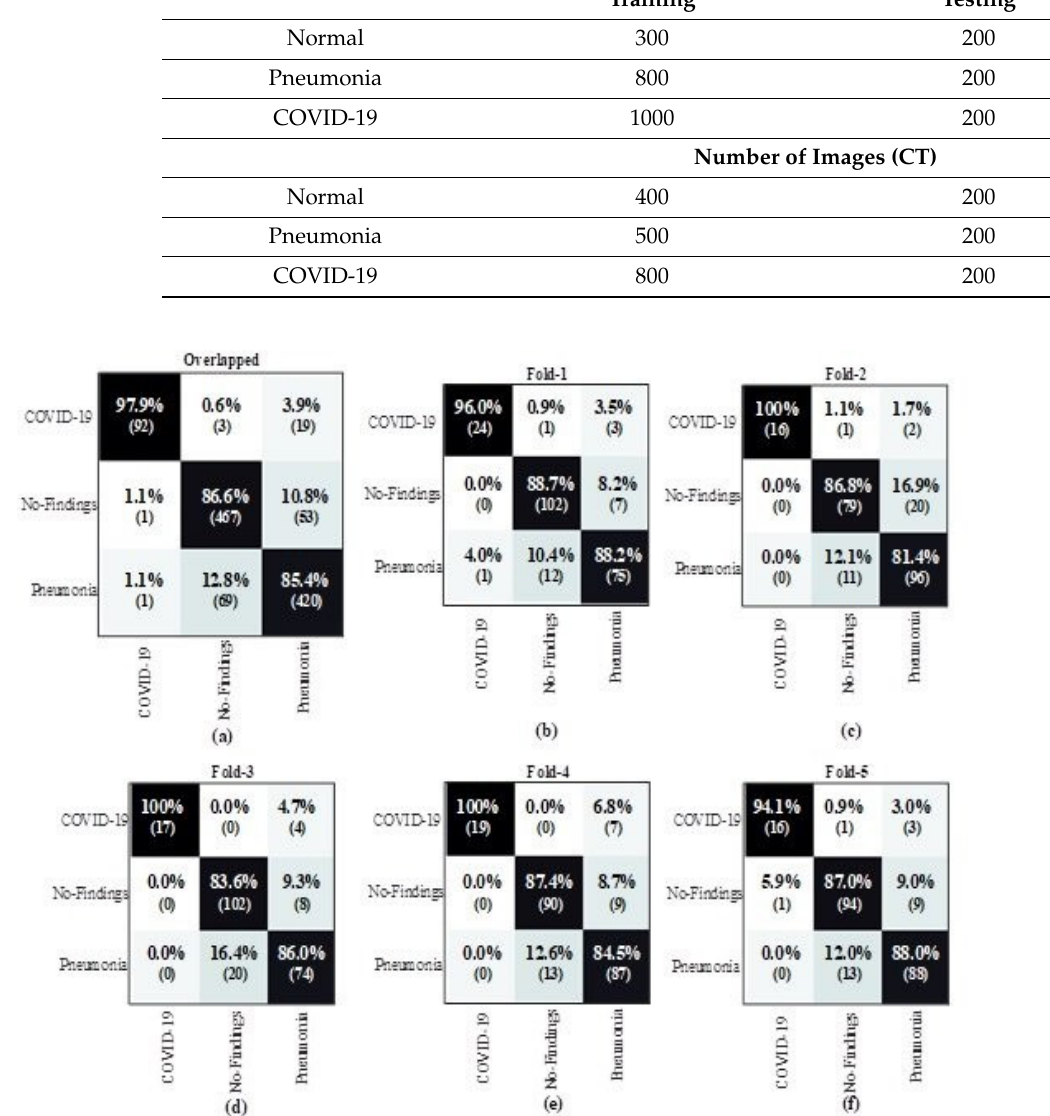
Figure 4. The 5-fold confusion matrix results of the multi-class classification task. ( a ) Overlapped Confusion Matrix, ( b ) 1-Fold Confusion Matrix (CM), ( c ) 2-Fold Confusion Matrix (CM), ( d ) 3-Fold Confusion Matrix (CM), ( e ) 4-Fold Confusion Matrix (CM), and ( f ) 5-Fold Confusion Matrix (CM).